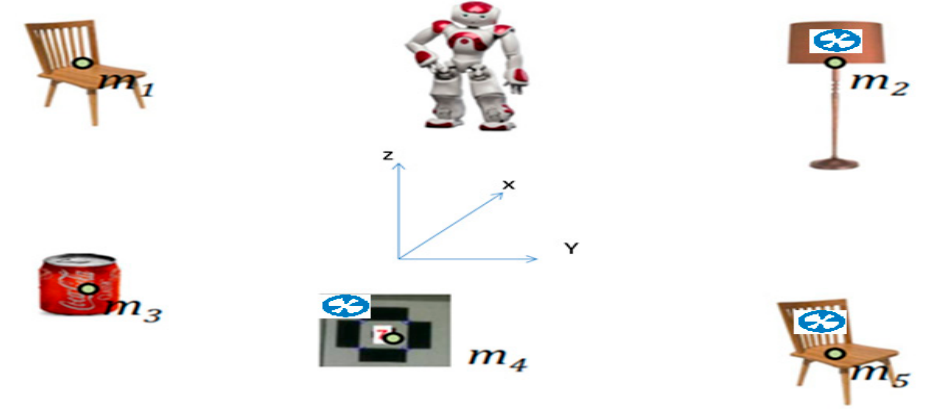
Figure 5. Augmented NAO mark in the environment.